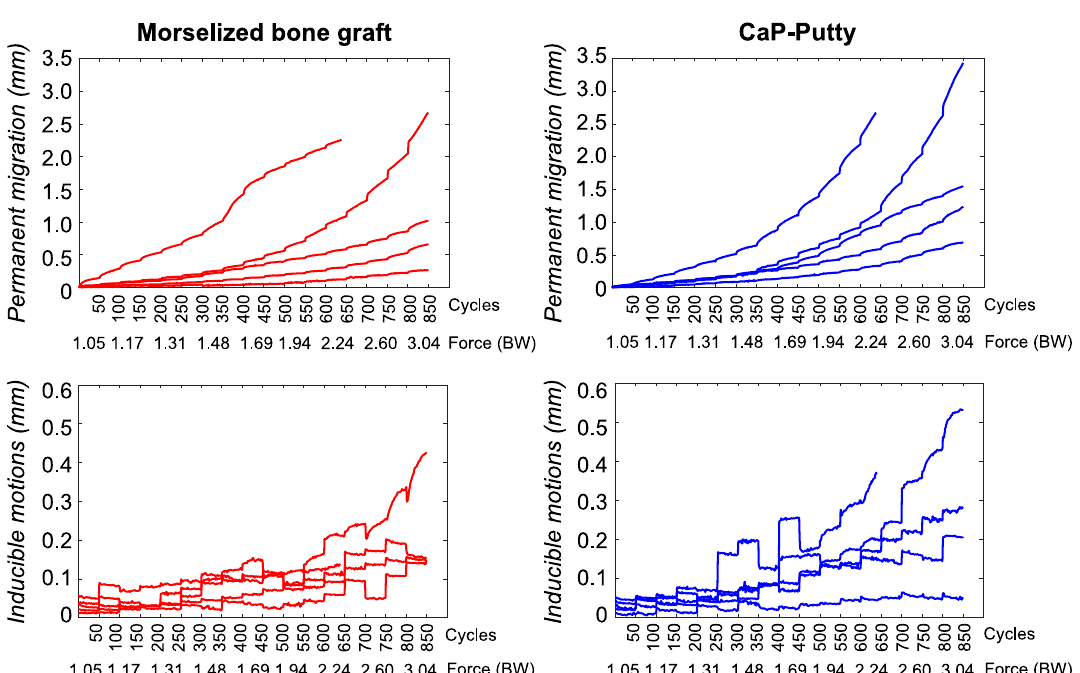
Figure 3. Morselized bone graft vs. CaP-putty : The resultant permanent migration and the resultant inducible micromotions measured during each test are shown for the morselized bone graft ( left , n = 5 specimens) and CaP-putty ( right , n = 5 contralateral specimens). On the x -axis the load cycles (in packages of 50 cycles) and the corresponding magnitude of the applied force are indicated. Motions during the preconditioning load package are not presented. Not-significant differences were found between the two groups (Wilcoxon signed rank sum test, p = 0.06–1.0 for the different load packages).